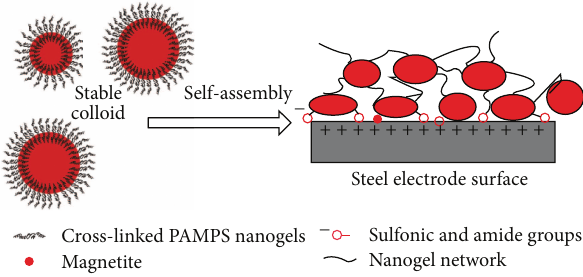
Figure 8: Mechanism of corrosion inhibition of Fe 3 O 4 /p(AMPS) nanogels on steel surfaces.